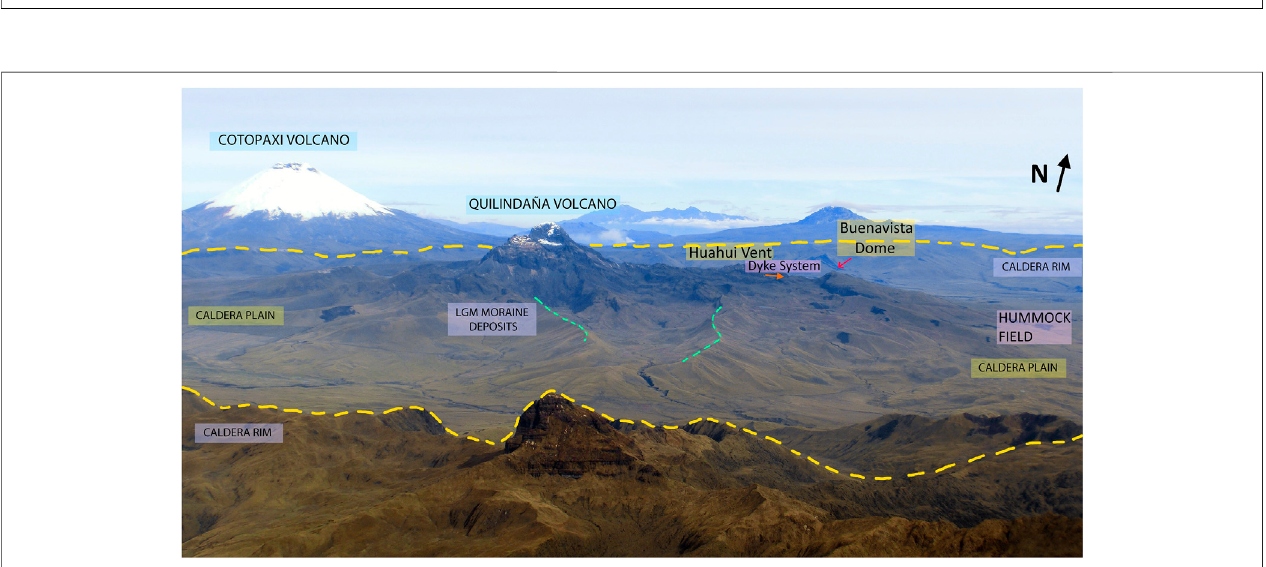
FIGURE 2 | Aerial view of the main structures of the Chalupas caldera, view toward W-NW, taken from above and slightly east of the caldera ’ s eastern rim (yellow broken line). LGM refers to moraines of the Last Glacial Maximum period and are demarcated by green lines.